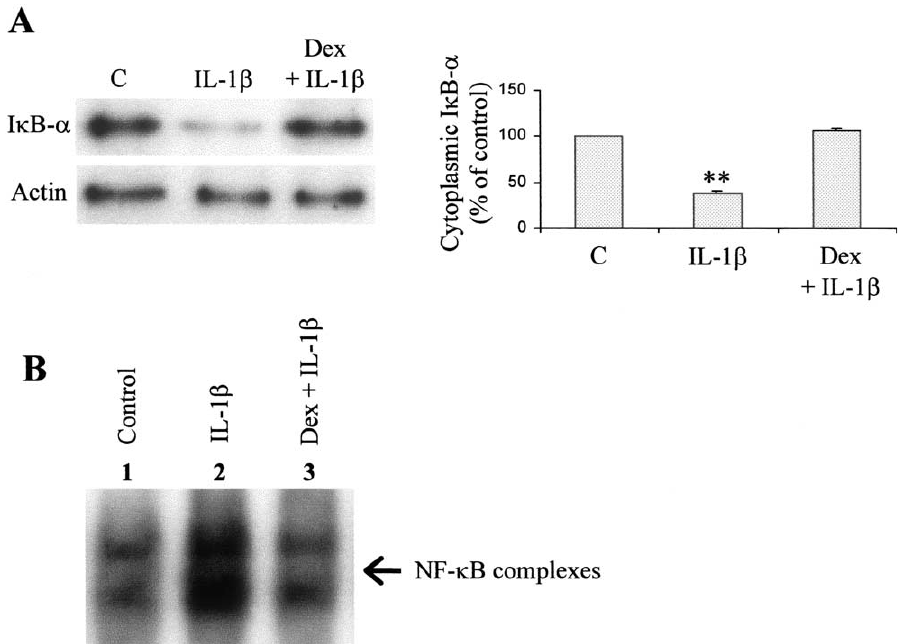
FIG. 6. Dex prevents IL-1 b -induced NF- k B activation. CCRF-CEM cells were treated with IL-1 b (20 ng/ml) for 30 min in the absence (lane 2) or in the presence of Dex (1 m M for 1 h; lane 3), or left untreated (control, lane 1). Cytoplasmic and nuclear extracts were prepared as described in Materials and methods. (A) The cytoplasmic I k B- a content was determined by western blot analysis, using a rabbit polyclonal anti-I k B- a antibody, and the bands were quantified with an image analyser. The results presented in the left panel are representative of four independent experiments. The data shown in the right panel are an average 9 / SD of four independent experiments. ** p B / 0.01, as determined by one-way analysis of variance with Dunnett’s post test. (B) Nuclear extracts from cells subjected to the same experimental conditions were analysed by electrophoretic mobility shift assay. The results are representative of three independent